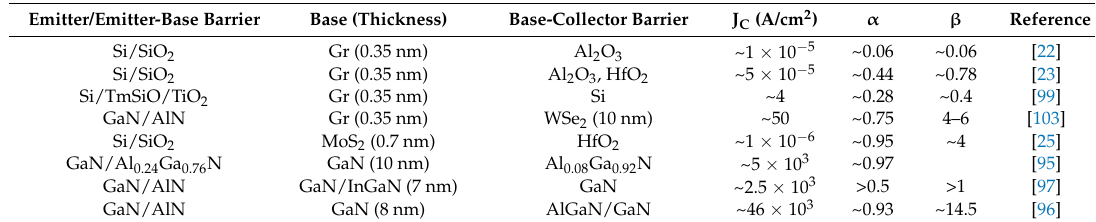
Table 1. Comparison of J C , α and β for the-state-of-the-art HETs with a Gr or MoS 2 base and for nitride semiconductor-based HETs with a sub-10-nm base thickness Emitter/Emitter-Base Barrier Base